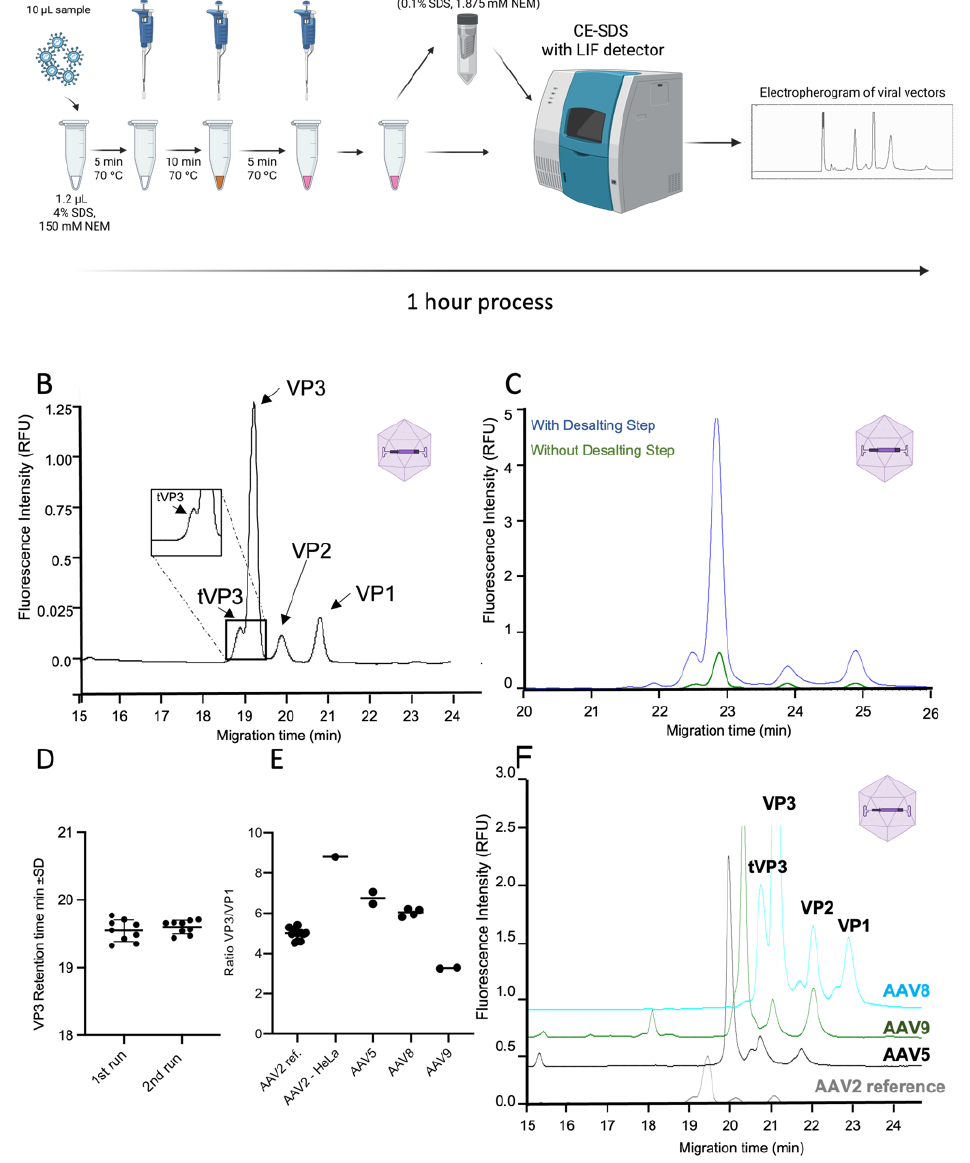
Figure 1. CE-SDS for the detection of AAV viral capsid proteins. ( A ) Representation of the methodology used for the analysis of viral proteins using CE-SDS coupled with a LIF detector. ( B ) Electropherogram of rAAV2 reference standard, displaying capsid proteins VP1, VP2, VP3, and tVP3. ( C ) Comparison of rAAV2 (9 × 10 11 TP/mL) electropherograms using desalting step (blue line) vs no desalting (green line). ( D ) Representation of VP3 migration time (min) for two different sample preparations ( n = 9 for each). ( E ) Comparison of CQA attribute (ratio VP3/VP1) for different AAV serotypes. ( F ) Overlay of the electropherograms of the different AAV serotypes; (HeLa3 AAV2 9 × 10 12 viral genomes (VG/mL), with rAAV5 (2 × 10 11 VG/mL), rAAV8 (5 × 10 12 VG/mL), and rAAV9 (7 × 10 12 VG/mL).